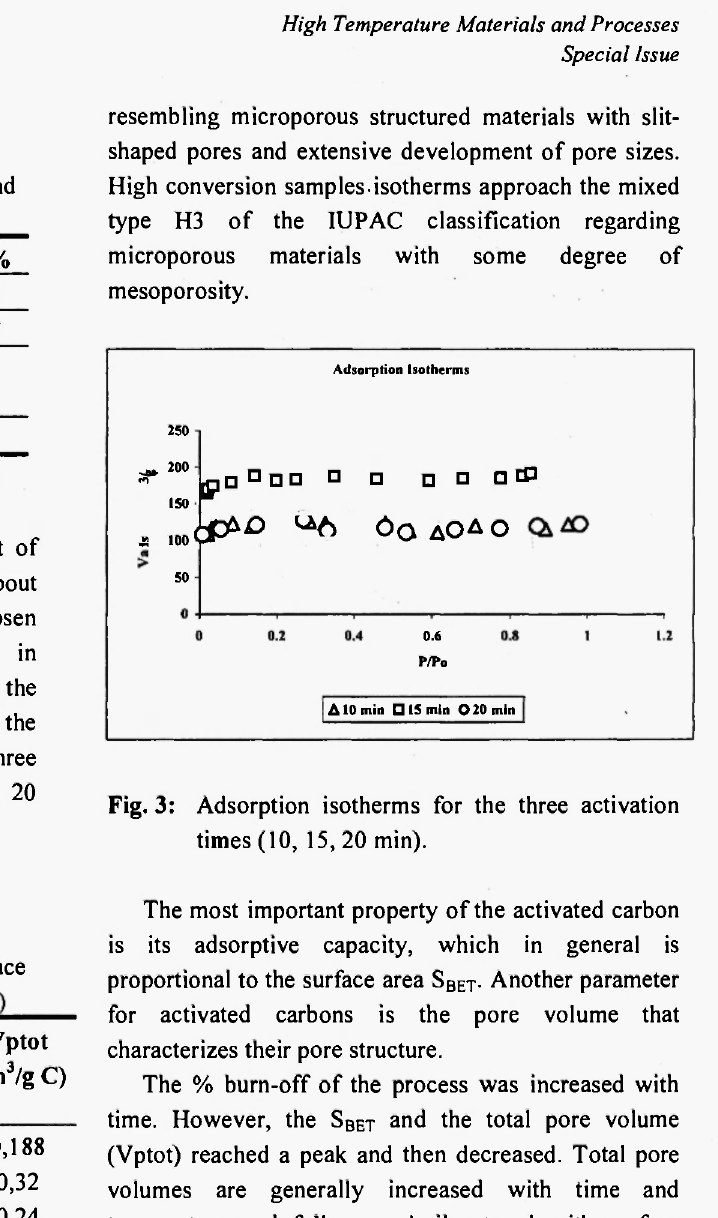
Fig. 3: Adsorption isotherms for the three activation times (10, 15,20